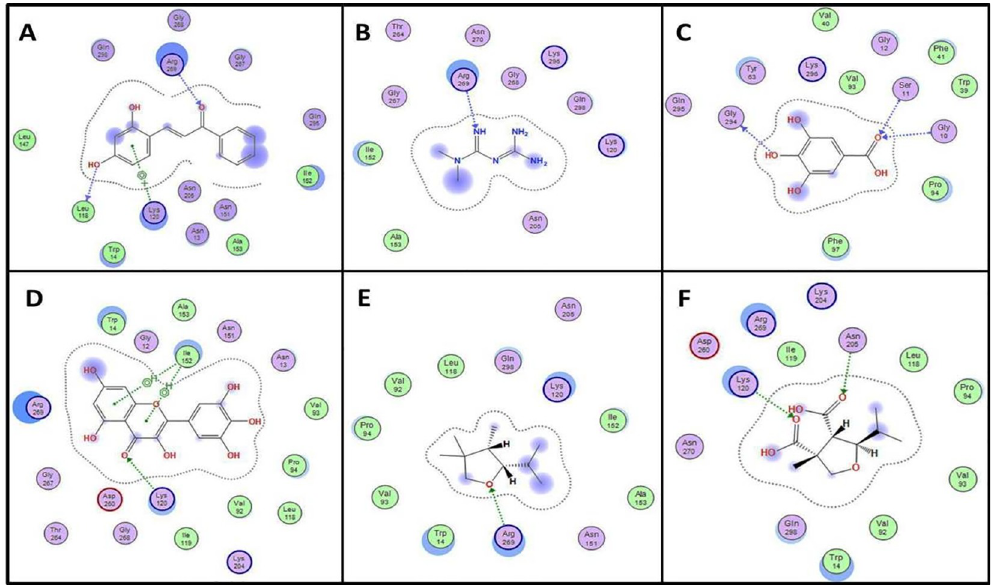
Fig 4. Enzyme ligand interactions of Limonium axillare phytoconstituents in the active site glycerol phosphate dehydrogenase. Diagrams representing 2D enzyme ligand interaction in the active site of GPDH with tested compounds A: 2’,4’ dihydroxychalcone, B: metformin, C: gallic acid, D: myricetin, E: compound 3 , F: compound 4 .